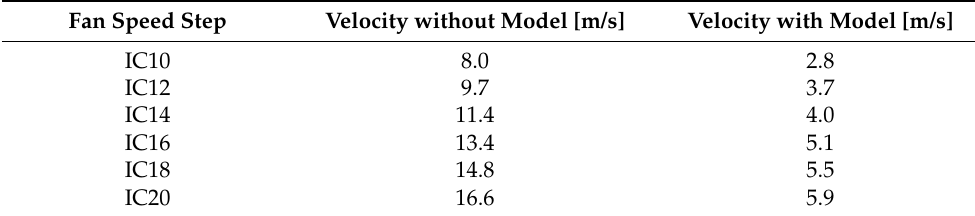
Table 1. The average velocity in measuring area T1; beam height of 388